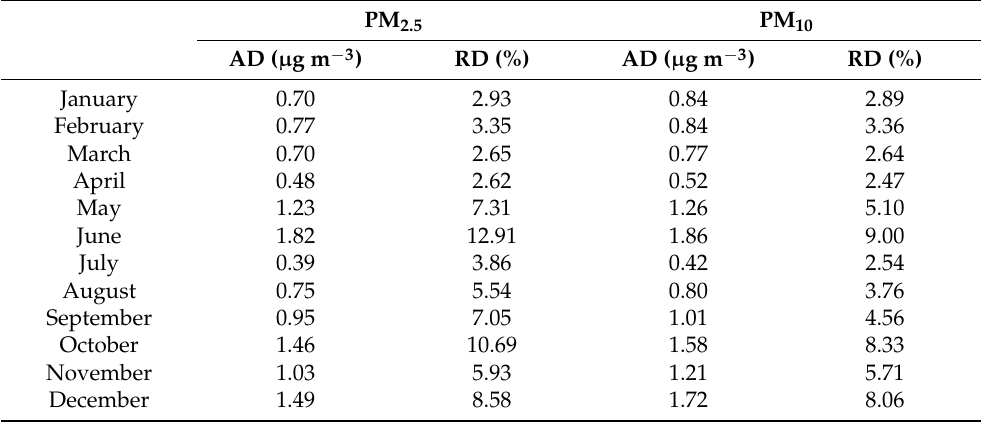
Table 5. Impacts of crop residue burning on the maximum concentrations of particulate matter at certain pixels in South Korea, in terms of absolute (AD) and relative differences